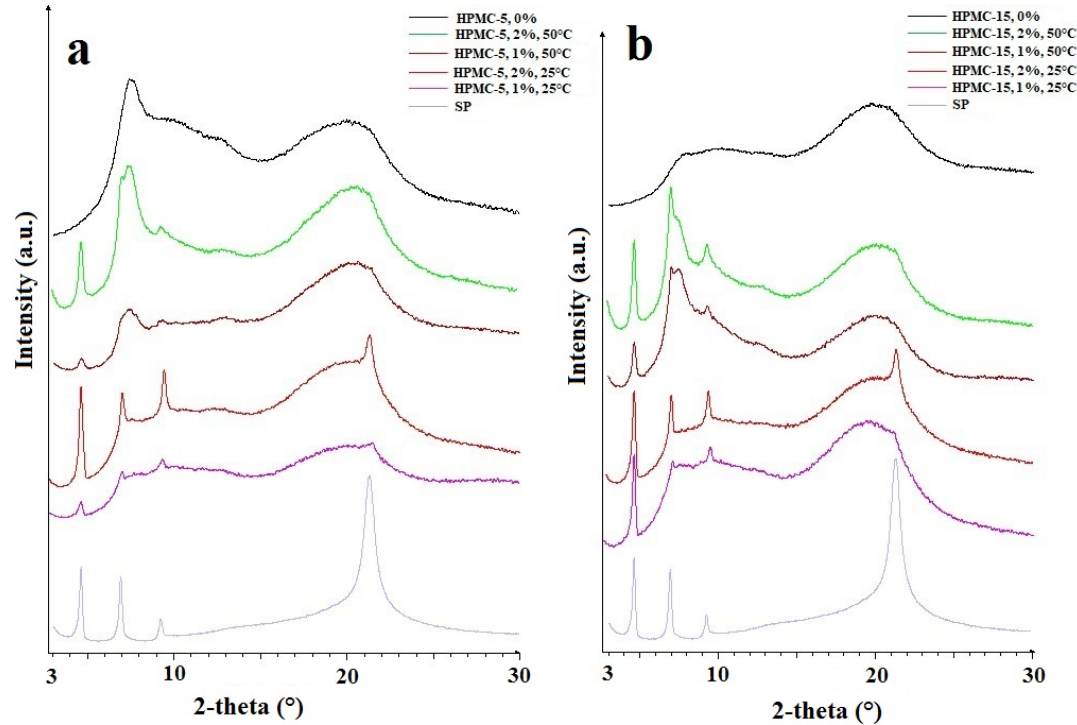
Table 5. The results of the X-ray powder diffractometry (XRPD) analysis.